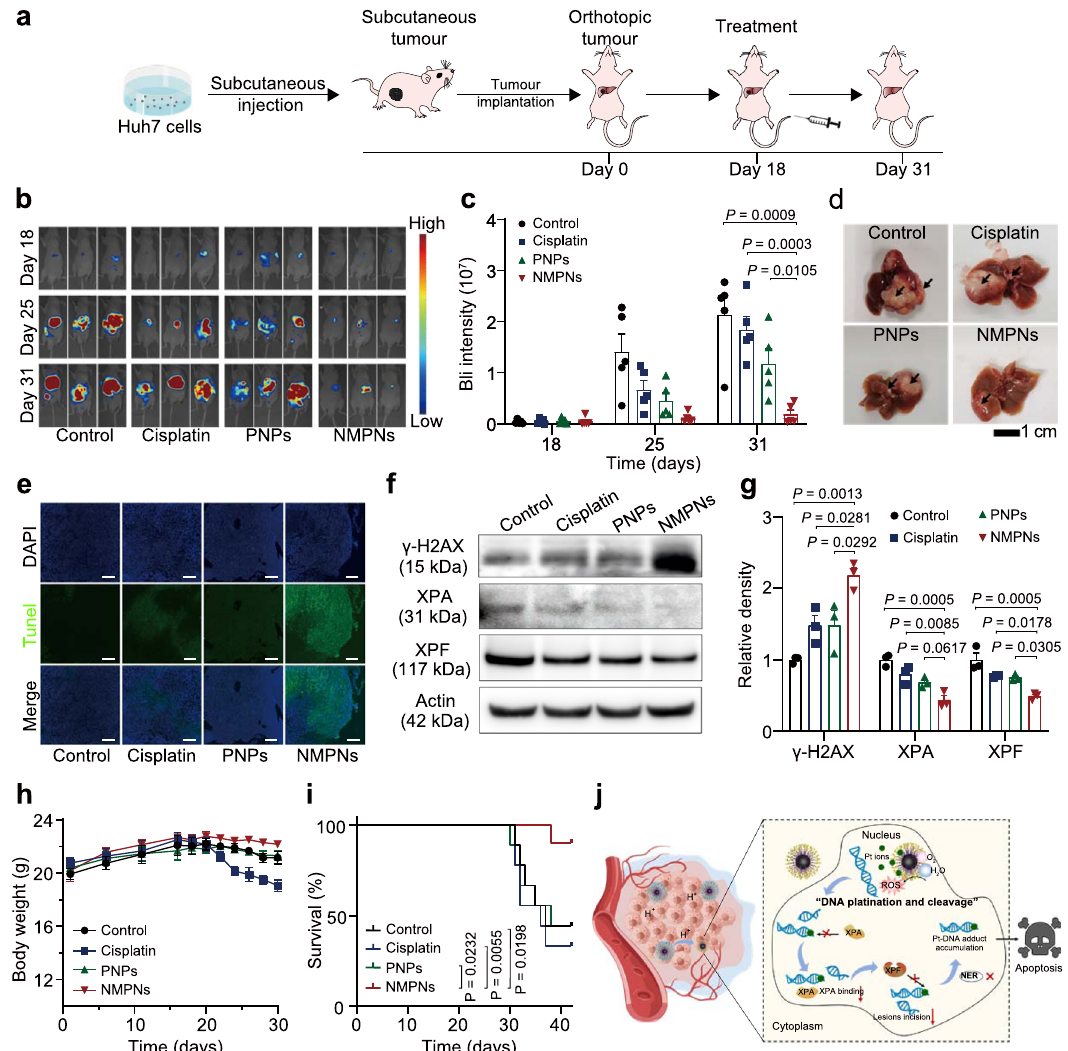
Fig. 7 | NMPNs suppress tumour in vivo and improve overall therapeutic out- come. a Schematic illustration of the establishment of orthotopic liver tumour micemodelandtreatmentprocess. b Representativebioluminescence(BLI)images ofeachgroupafterdifferenttreatments. c QuantitativeBLIsignalsoftumoursafter different treatments. n =5 mice. Statistical signi fi cances were analyzed by two- tailed unpaired Student ’ s t -test. d Representative images of liver collected from each treatment group on day 31. Black arrows indicate the tumour tissues. e RepresentativeTUNELandDAPIstainingimagesoftumourtissues.Scalebar:200 μ m. f , g Western blot analysis and quantitative analysis of γ -H2AX, XPA and XPF